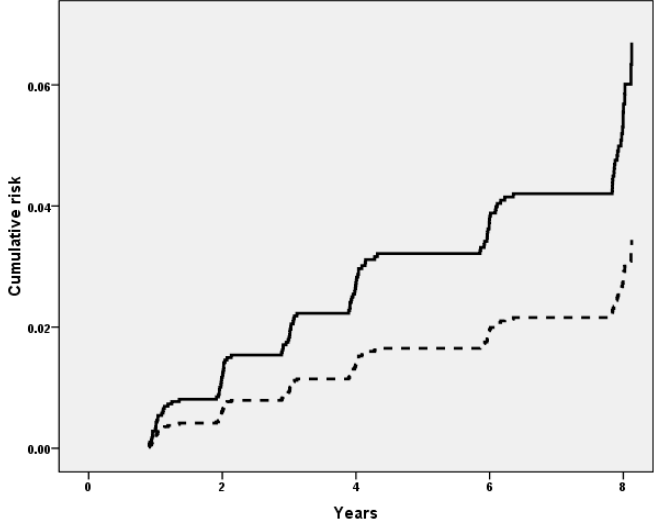
Figure 1. Risk of incident frailty in men by Recommended Dietary Allowance at baseline. Legend: the continuous line represents men not reaching the corresponding RDA at baseline; and the dashed line represents men reaching the RDA.